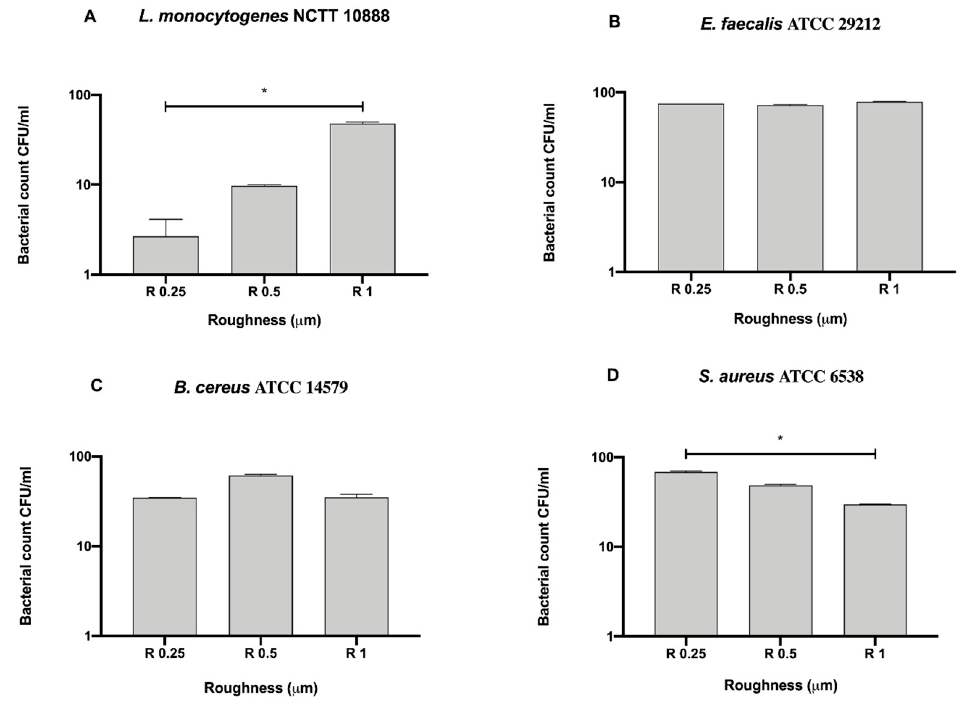
Figure 10. Antibacterial activity of different surface roughness on DURALTI ® ‐ treated disks against Gram-positive bacteria ( A ) L. monocytogenes NCTT 10888, ( B ) E. faecalis ATCC 29212, ( C ) B. cereus ATCC 14579 and ( D ) S. aureus ATCC 6538, * p < 0.05.